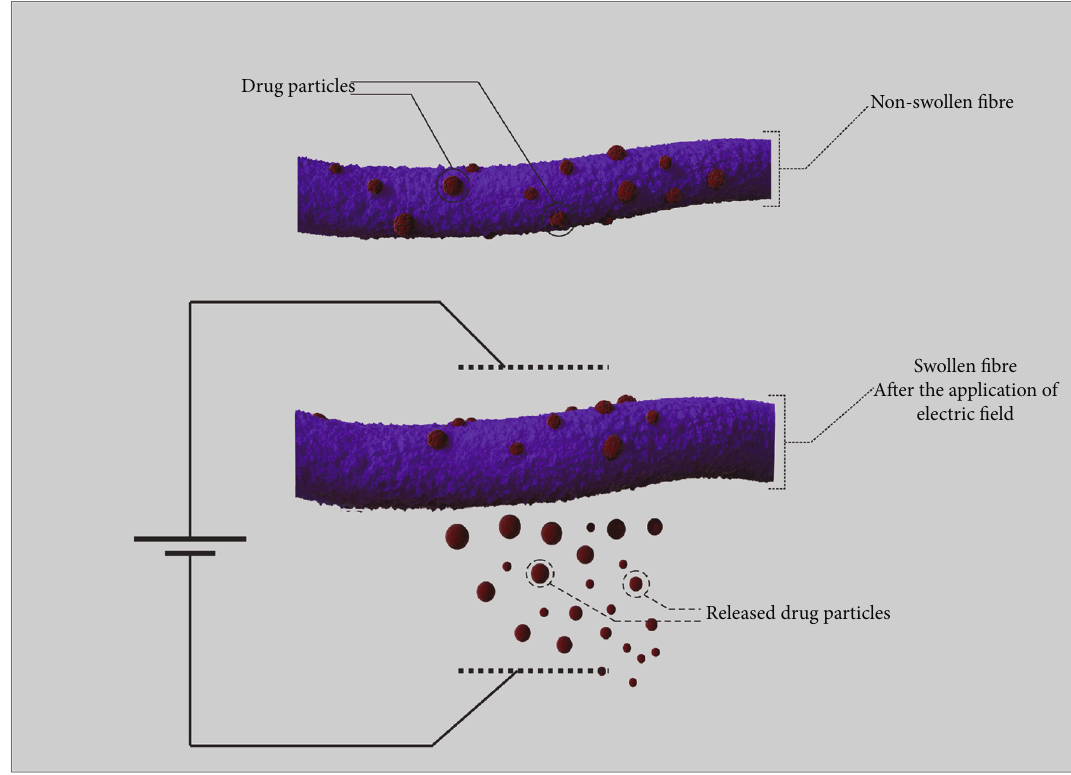
Figure 8: Release behavior from electro-responsive fi